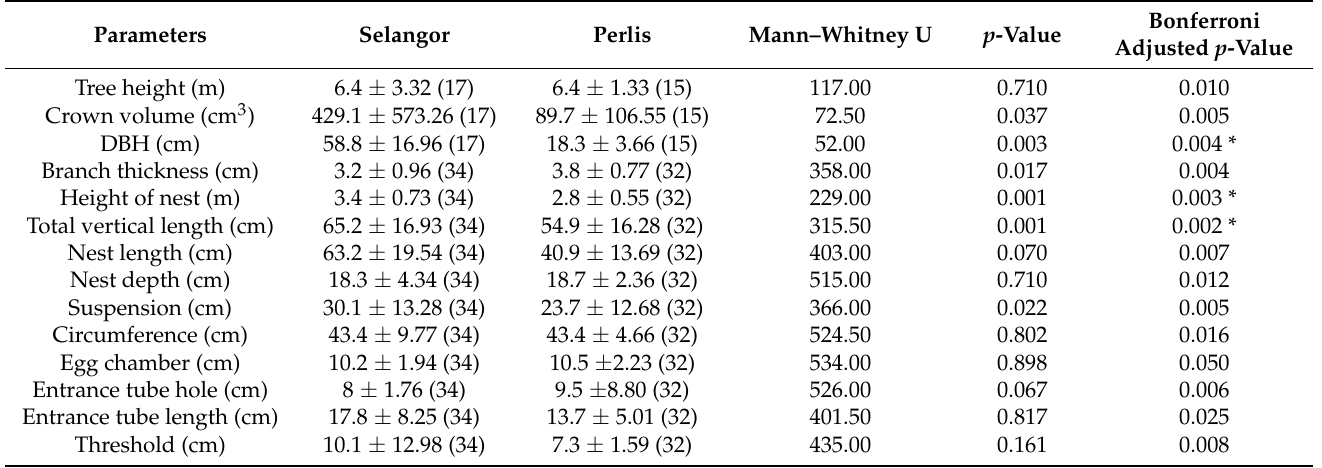
Table 1. Characteristics of the baya weaver ( Ploceus philippinus ) nest trees and active nests at the Selangor and Perlis colonies. Values are average ± SE, with n in parentheses. p -values based on Mann–Whitney U tests.